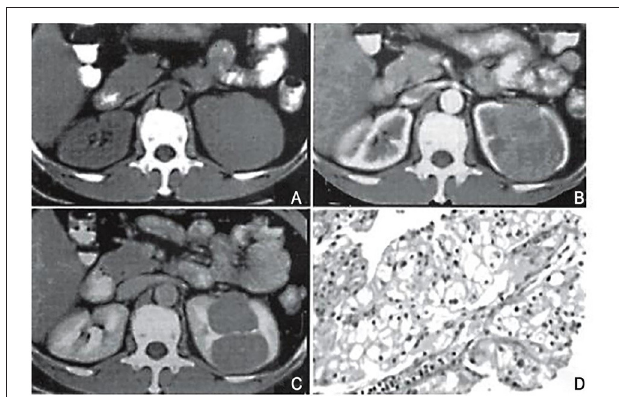
FIGURE 2 | Case 1, female, 51 years old. CT classification: limited convex type. (A) Flat scan: an isobaric soft tissue mass in the upper part of the left kidney is partially protruding out of the contour of the kidney, with a smooth edge. The density of the lesion is uniform, and the boundary with the kidney tissue is unclear. (B) Arterial phase: the tumor shows obvious uniform enhancement, with clear borders and lobules. The lesion is locally convex but the surface is smooth. (C) Delayed scan: the tumor density is reduced, but the borders are clear, and a pseudo-capsule is formed around it. Surgery pathological biopsy (HEx200). The tumor tissue is arranged in a papillary shape. The image is a longitudinal section of a nipple, with a longitudinal section of a blood vessel visible in the center. Cancer cells are round-shaped, with transparent cytoplasm, and nuclei in the center or